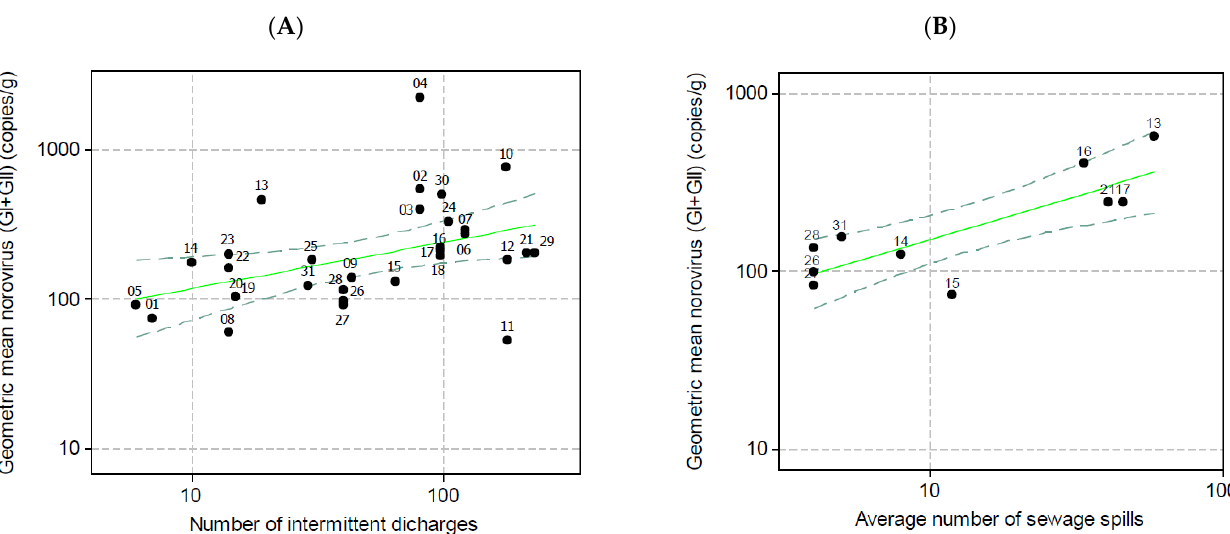
Figure 5. Linear relationships between mean concentrations of norovirus and the number of storm overflows ( A ) (log 10 geometric mean NoV = 1.758 + 0.3120 ∗ log 10 number of discharges; p < 0.019; R 2 adj = 15%)/average number of spills ( B ) (log 10 geometric mean NoV = 1.688 + 0.4904 ∗ log 10 average number of spills; p < 0.001; R 2 adj = 62%). Reproduced from Campos (2015) [45]. Numbers above black dots identify sampling sites as defined in Campos (2015). Continuous green lines represent linear regressions. Dashed green lines represent 95% confidence